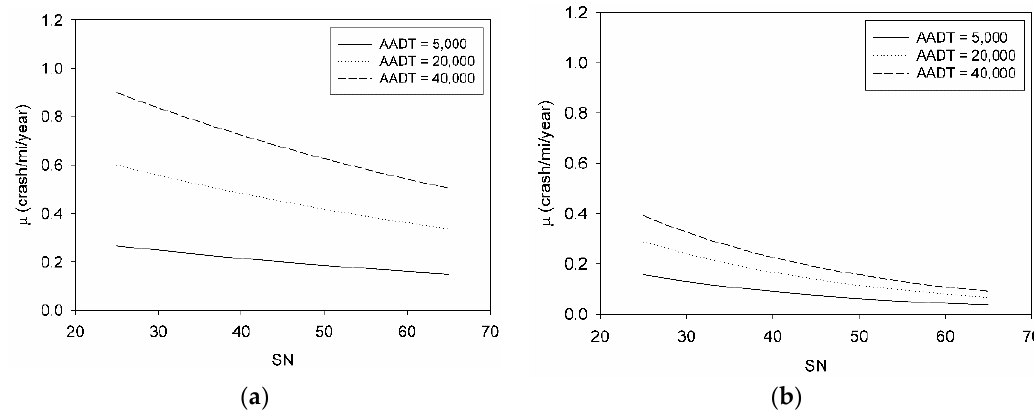
Figure 7. Expected crash rates as a function of SN, AADT, and SL; as explained by the NB regression models for ( a ) dry and ( b ) wet environmental surface conditions.